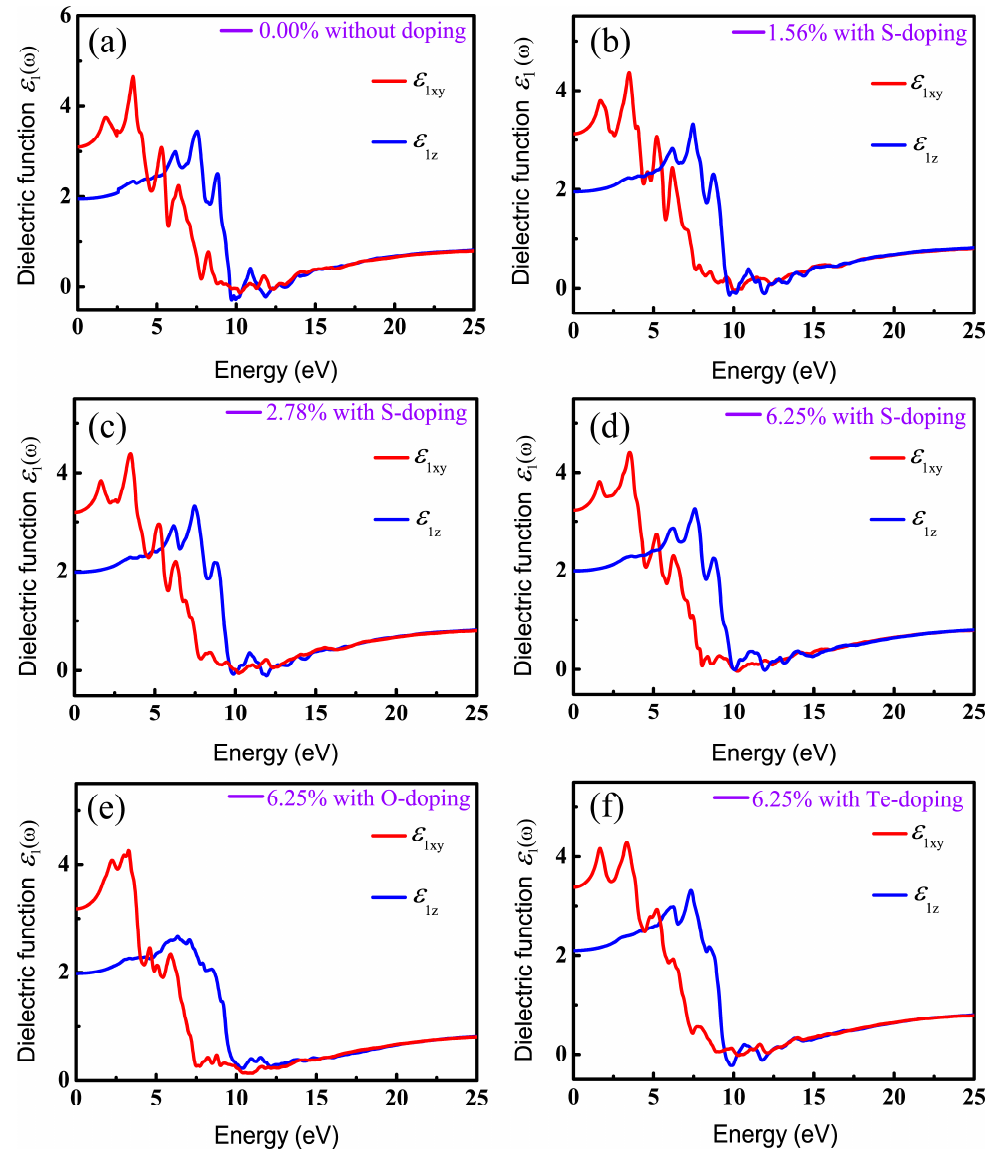
Figure 7. Real parts of dielectric function ε 1 ( ω ) in xy plane and along z direction, versus photon energy: ( a ) pristine monolayer CSe; ( b – d ) S-doping at concentrations of 1.56%, 2.78% and 6.25%, respectively; ( e ) O-doping at 6.25%; ( f ) Te-doping at 6.25%.